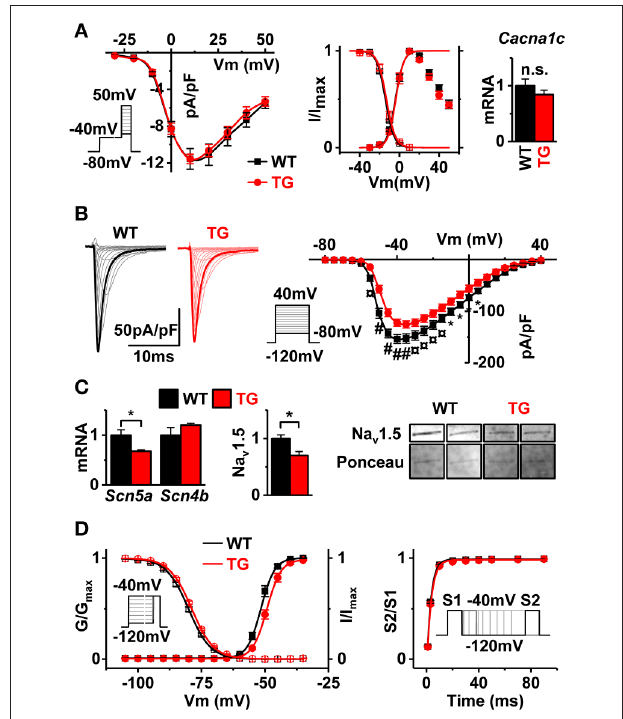
FIGURE 5 | Depolarizing currents in VEGF-B TG myocytes. (A) I–V curves of I CaL densities (left panel, WT n = 9 and TG n = 11, myocytes from three animals in both groups), voltage-dependent activation/inactivation of I CaL (middle panel, Boltzmann fitting) and gene expression of α -subunit calcium channel ( Cacna1c , right panel). (B) Typical sodium channel current traces (left panel) and I–V curves (right panel) (WT black line, n = 19 and TG red line n = 14 myocytes from 3 mice were used for both groups). (C) Gene expression of sodium channel subunits Scn5a and Scn4b (left, WT n = 7 and TG n = 6) and Western blot of Na v 1.5 from membrane protein fraction. Na v 1.5 western blot signal normalized to Ponceau stain (middle, WT n = 3, TG n = 4). Representative SCN5a bands and Ponceau stain from the same region of the membrane (right). (D) Voltage-dependent activation and inactivation of sodium channels (left panel) and recovery time from inactivation (right panel) (see Table S3 for fitting results, WT n = 19 myocytes and TG n = 15 myocytes from three animals in both groups). Refer to insets for voltage-step protocols. * P < 0.05, ¤ P < 0.01 and # P <